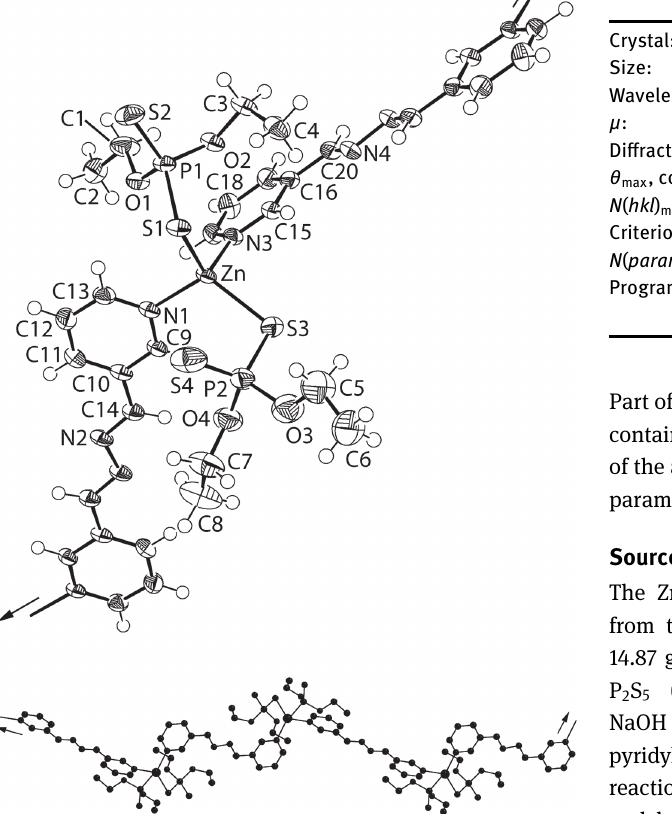
Table 1: Data collection and